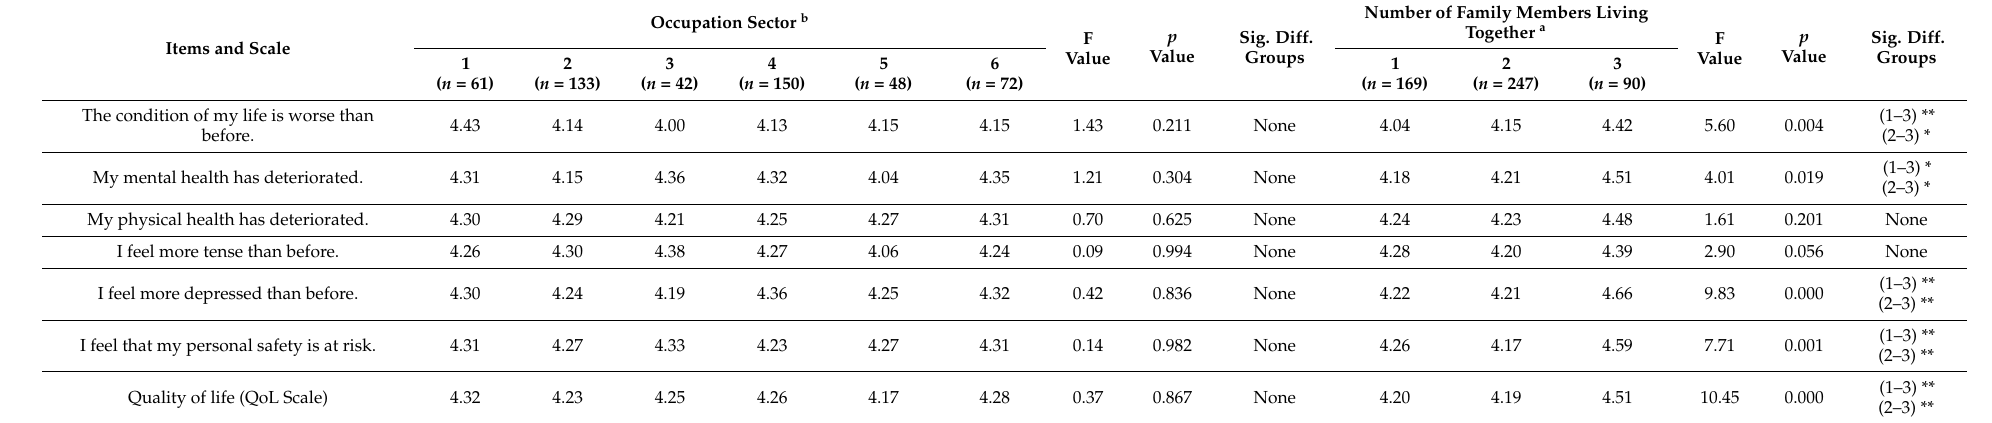
Table 4. ANOVA for mean scores of respondents on QoL items and QoL scale classified by number of family members living together and occupation